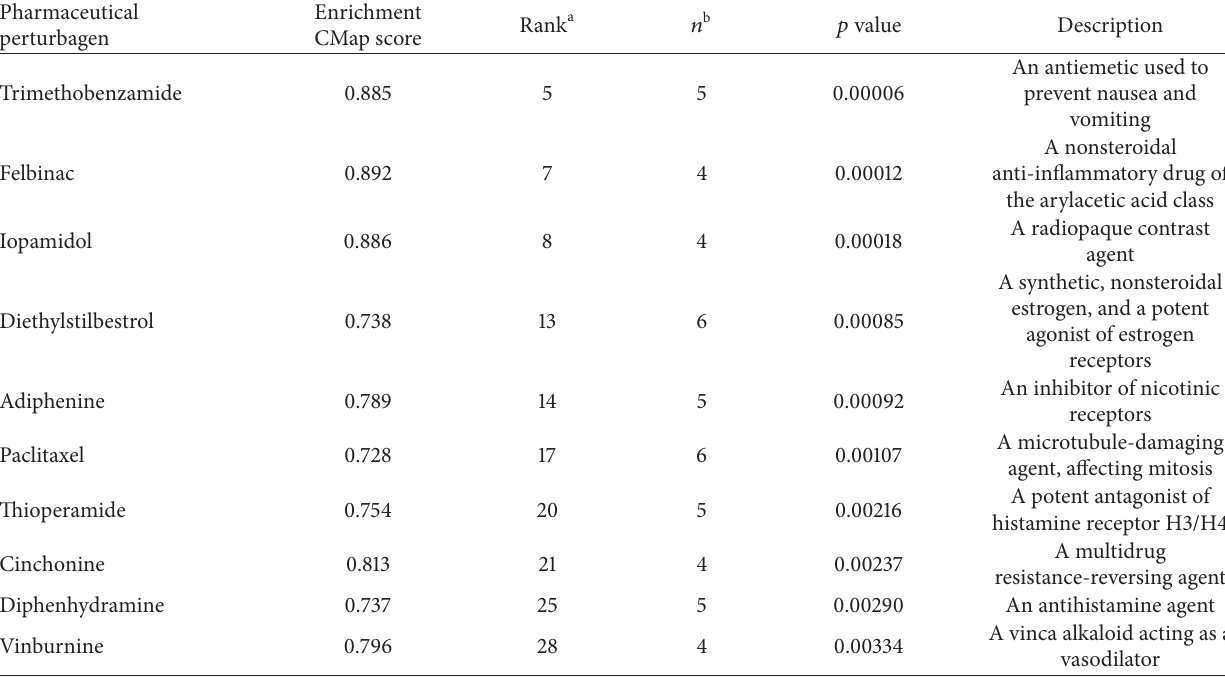
Table 5: Top 10 perturbagens identified through the Connectivity Map that induce the CDH-associated signature. Pharmaceutical